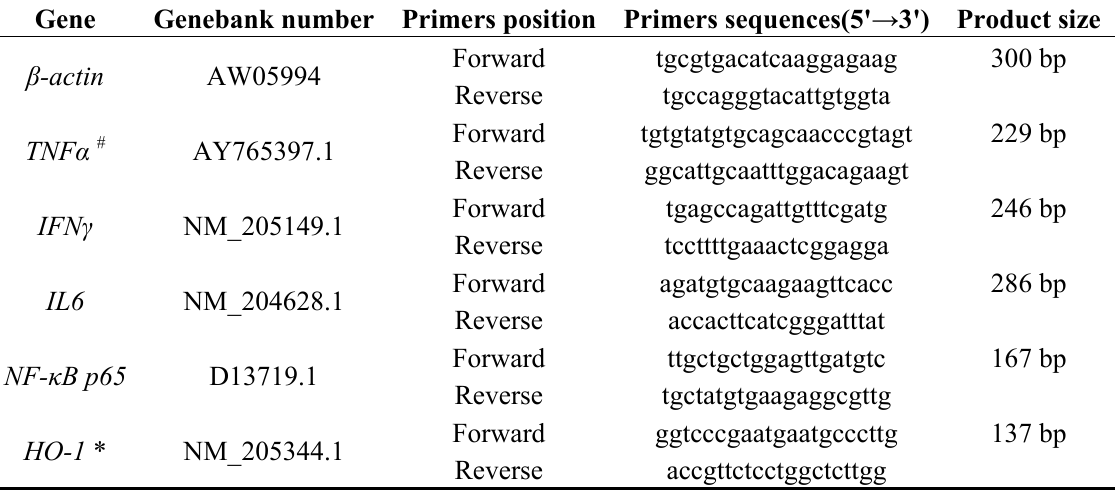
Table 1. Gene-specific primer of related